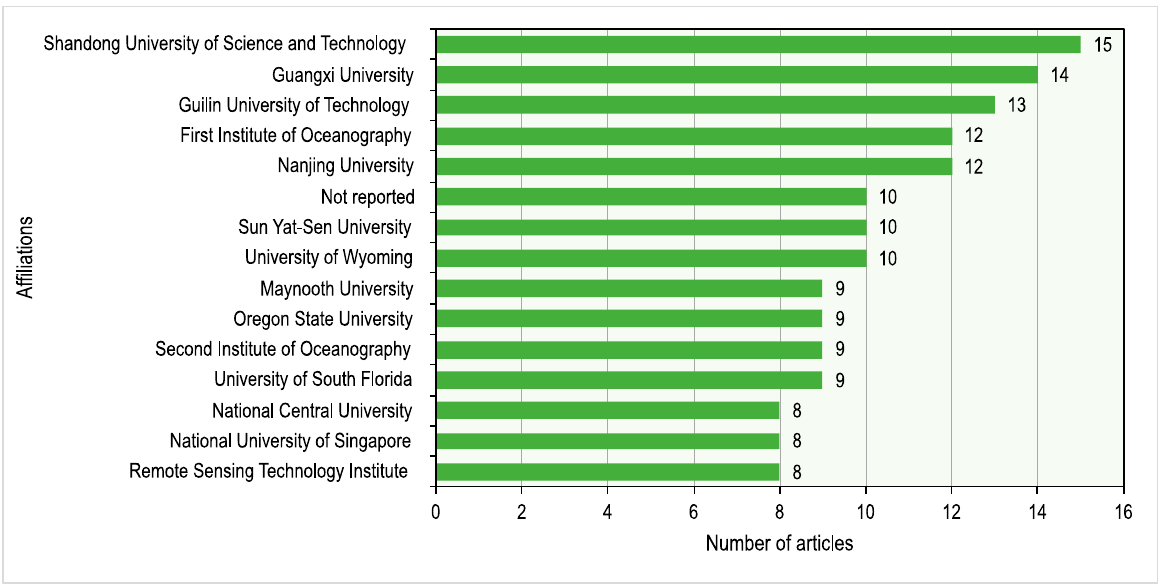
Figure 8. Most relevant affiliations that published optical SDB articles by the number of articles.